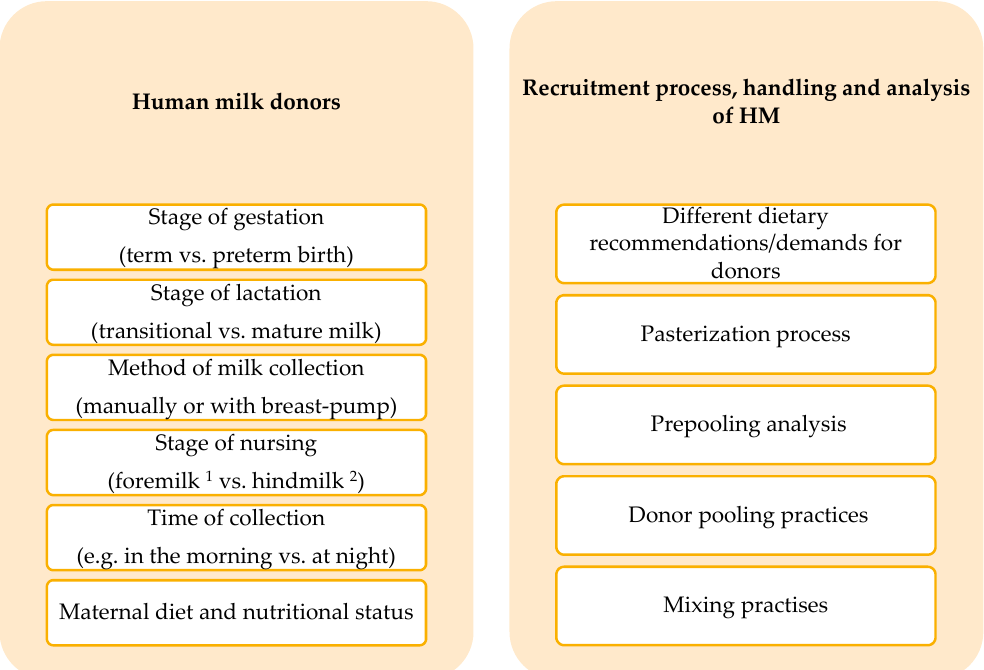
Figure 1. Potential sources of variation in composition of DHM. 1 foremilk — milk produced at the beginning of the feeding, 2 hindmilk — milk produced at the end of the feeding.